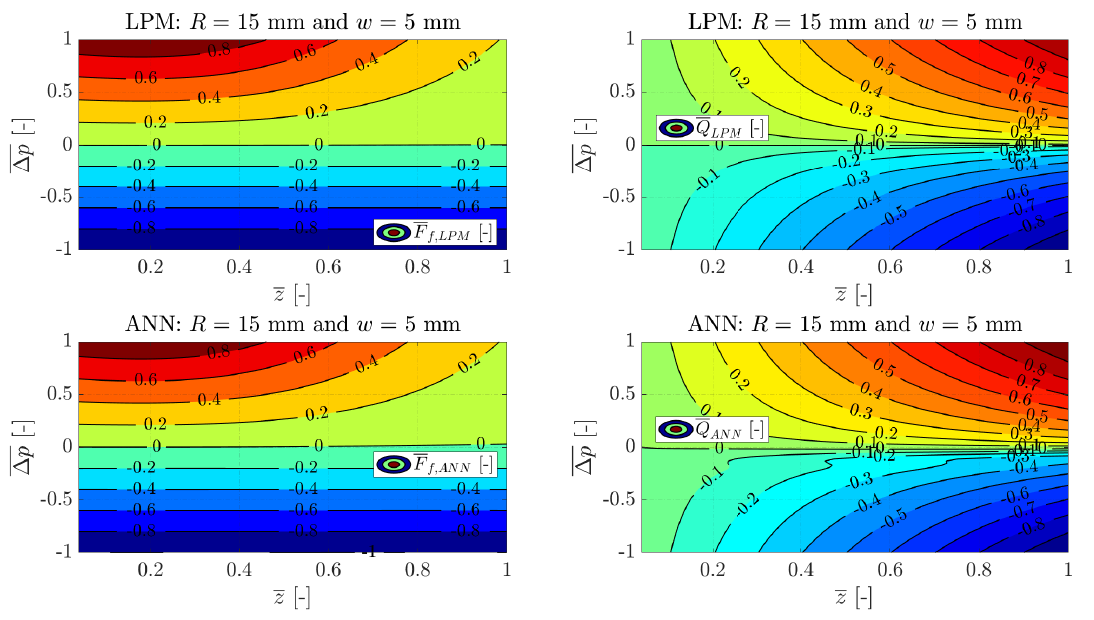
Figure 11: Normalized flow and flow force values from the LPM and 2-dimensional ANN where R = 15 & w = 5 mm. These are used to compute the residuals of Figure 12 defined by Equation